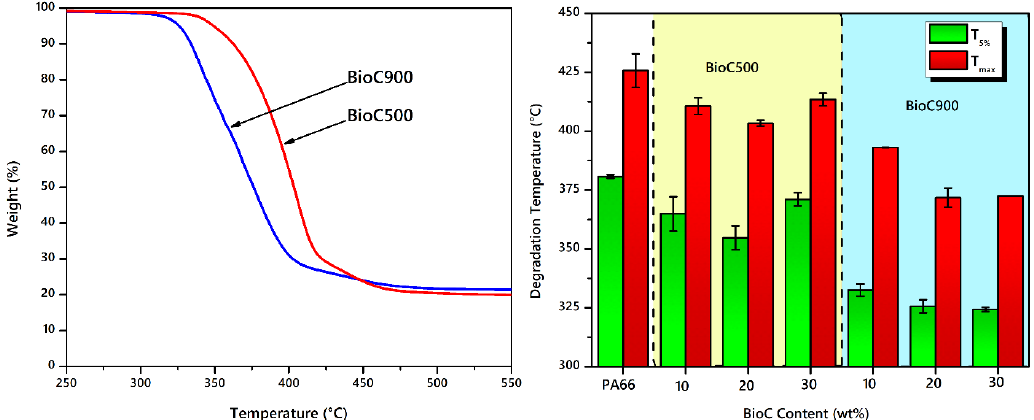
Figure 6. ( a ) Thermogravimetric analysis (TGA) curves of BioC / PA66 biocomposites at 20 wt% and ( b ) comparison of degradation temperature at 5% weight loss and maximum decomposition of BioC / PA66 biocomposites.